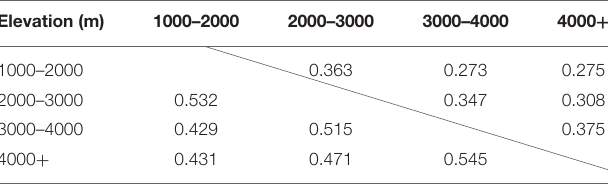
TABLE 4 | Similarity index of fungal endophytes isolated from different elevations at the genera level. Elevation